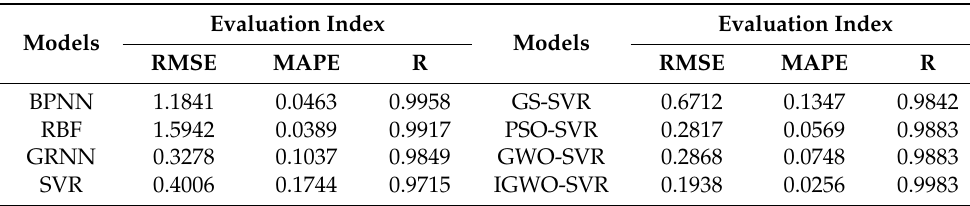
Table 3. RMSE, MAPE, and R mean results for subject S1 under different regression models at the joint angle of 90.